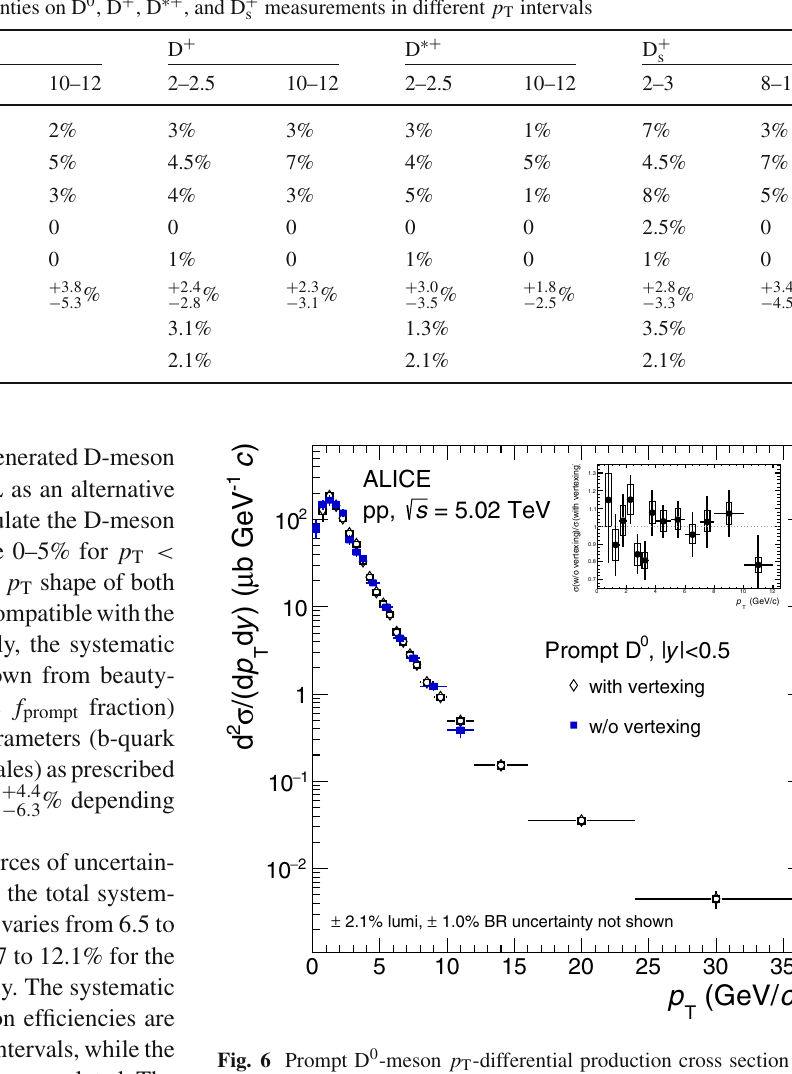
Fig. 6 Prompt D 0 -meson p T -differential production cross section in √ | y | < 0 . 5 in pp collisions at s = 5 . 02 TeV measured with and without decay-vertex reconstruction. The inset shows the ratio of the measure- ments in their common p T range. The vertical error bars and the empty boxes represent the statistical and systematic uncertainties, respectively depicted as boxes around the data points. In each p T interval thesymbolsarepositionedhorizontallyatthecenterofthebin and the horizontal bars represents the width of the p T inter- val. The two results for prompt D 0 -meson cross section are found to be consistent within statistical uncertainties, which are independent between the two measurements because of their very different signal-to-background ratios and efficien- cies. The most precise measurement of the prompt D 0 -meson production cross section is obtained using the results of the analysis without decay-vertex reconstruction in the interval 0 < p T < 1 GeV / c and those of the analysis with decay- vertex reconstruction for p T > 1 GeV / c